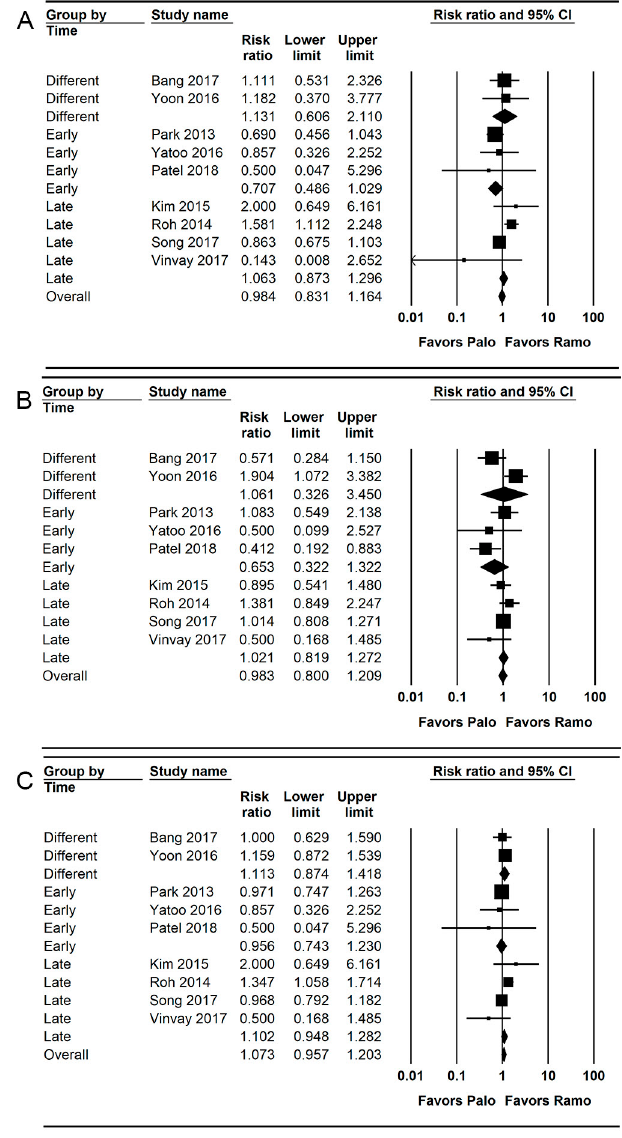
Figure 5. Forest plot of studies comparing the effectiveness of palonosetron with that of ramosetron on PONV. ( A ) Early, ( B ) late, and ( C ) overall. The size of the filled squares of risk ratios reflects the effect size of individual trials. Horizontal bars represent 95% confidence intervals of difference. The diamond depicted the pooled estimates and uncertainty of the combined effect. The combined results showed no evidence of differences between palonosetron and ramosetron for early, late, and overall PONV. For subgroup analysis, no evidence of differences was observed between palonosetron and ramosetron according to administration time.